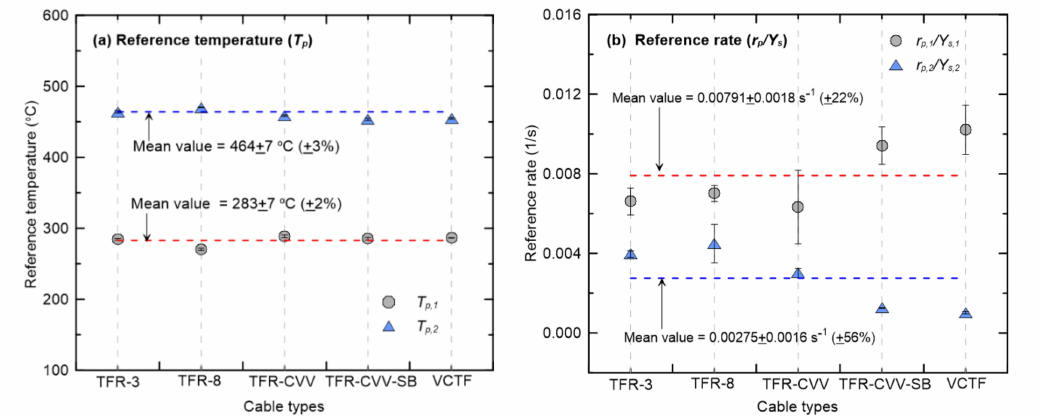
Figure 8. Reference temperatures and rates of the two dominant pyrolysis reactions for flame retardant cables